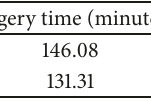
Table 3: In cases that developed an infection, there was a reduced surgery time for cases performed at the dedicated orthopaedics hospital compared to the general university